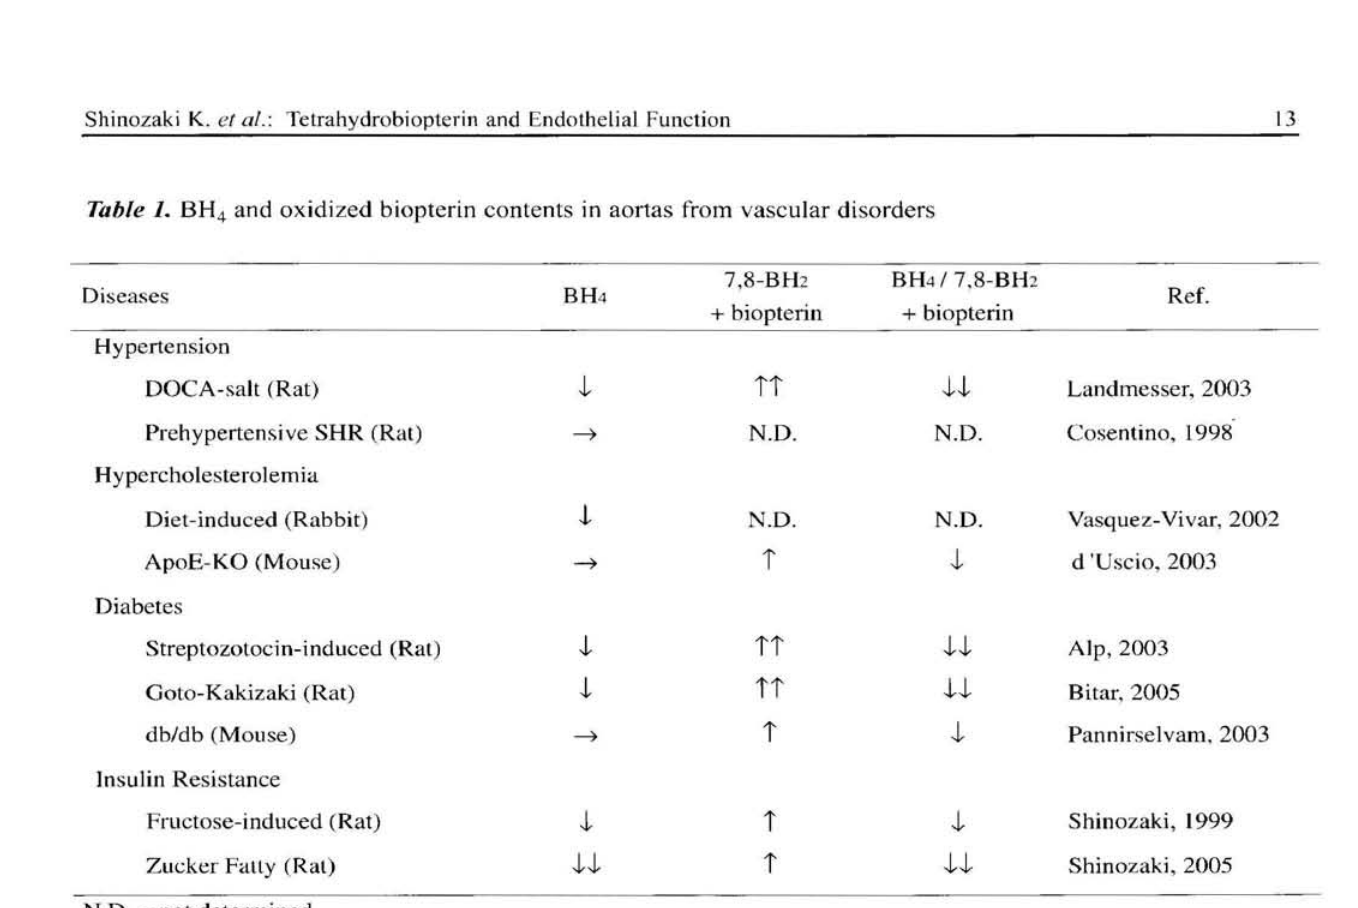
Table 1. BH4 and oxidized biopterin Contents in aortas from vascular disorders Diseases BH4